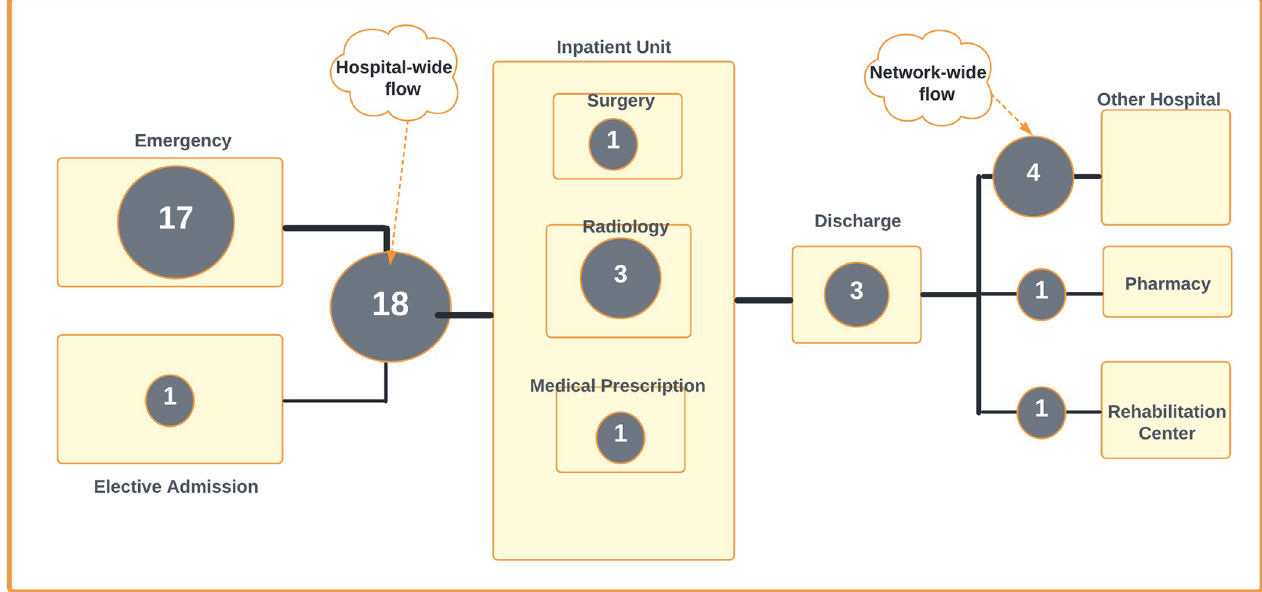
Fig 2. Focused patient flow areas of the reported HISs. The numbers in the circles correspond to the number of relevant studies reviewed.